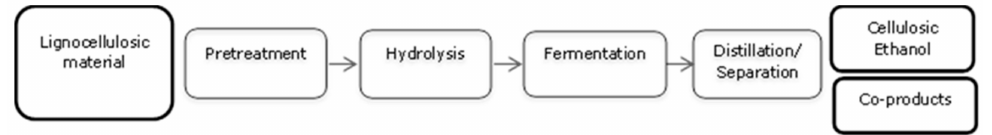
Figure 1. Cellulosic ethanol